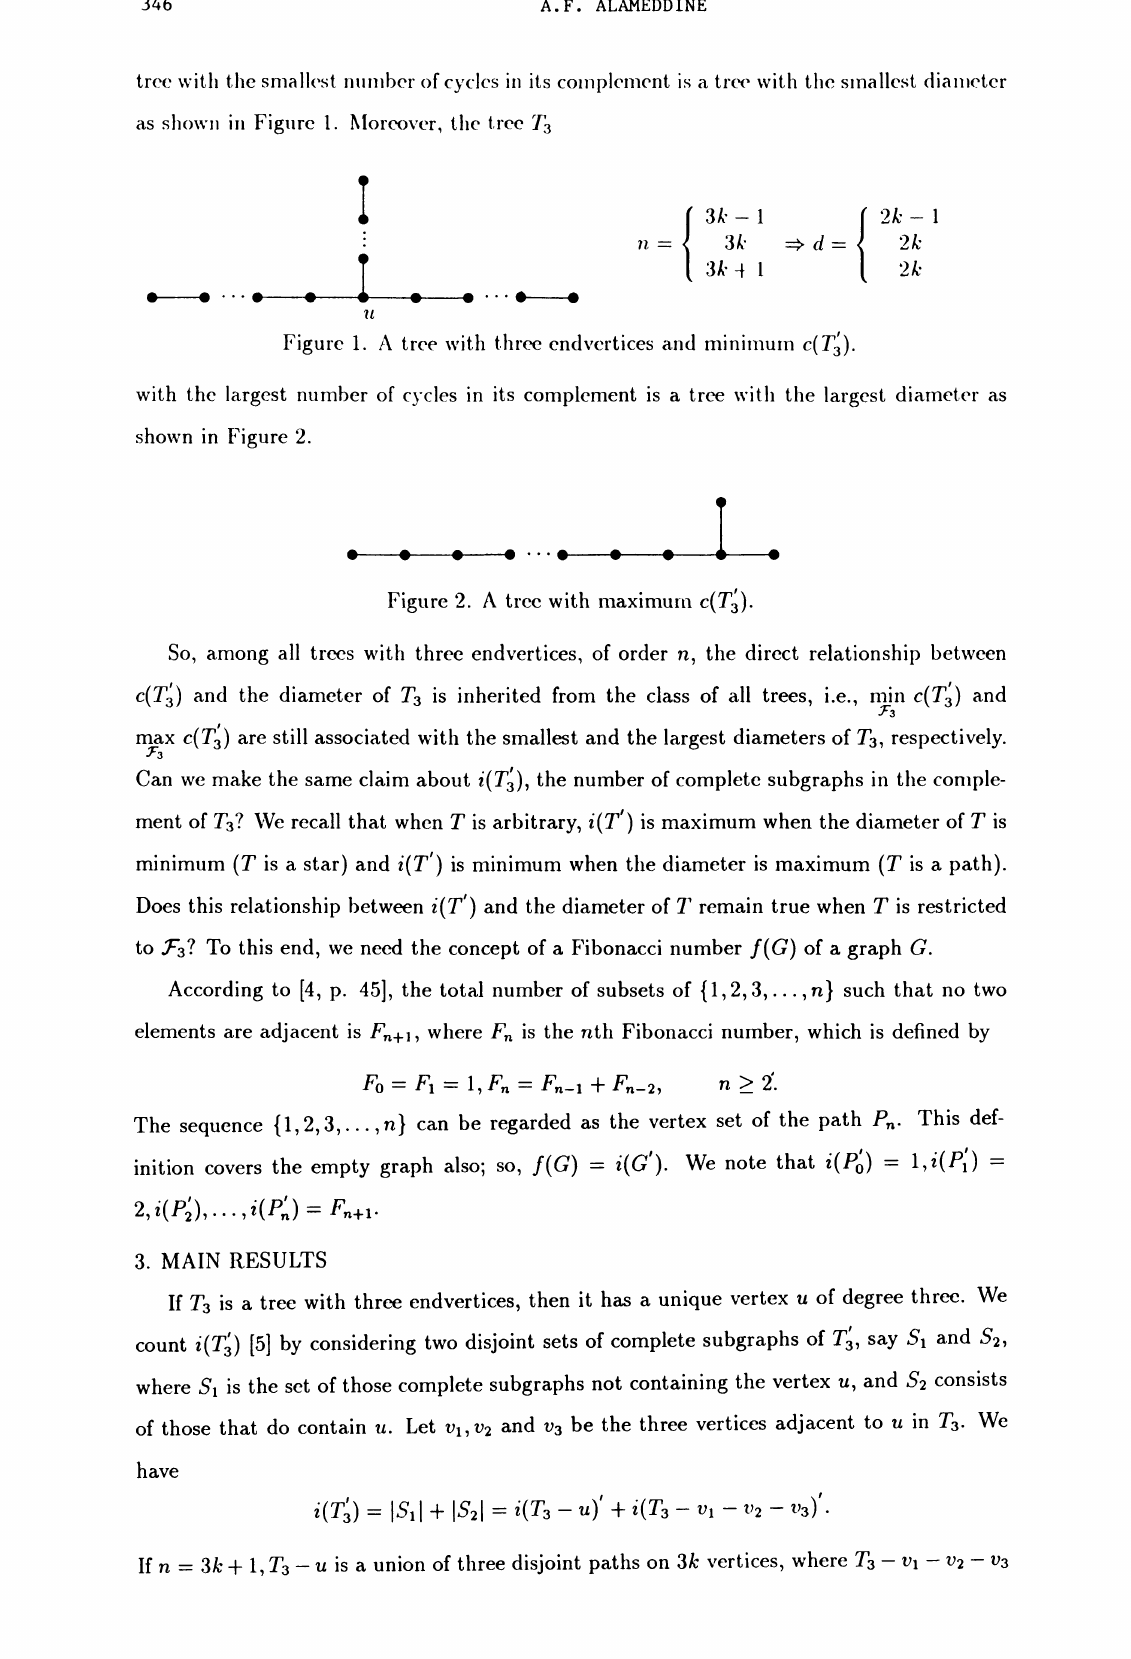
Figurc 1. A trce with three cndvcrtices and minimun c(T).